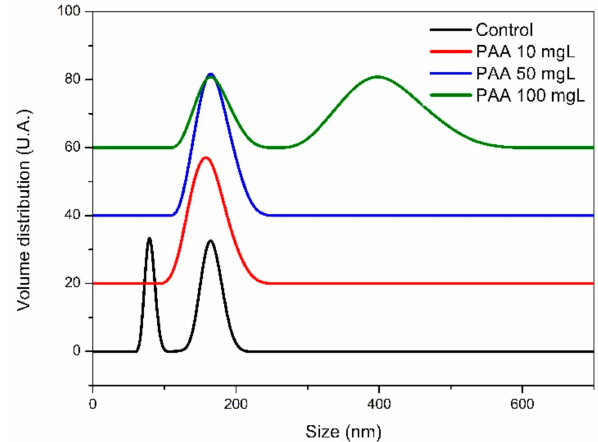
Figure 4. In situ DLS analysis of particle size distribution (PSD) of particles formed during the titration experiments in the absence and in the presence of three concentrations of PAA.